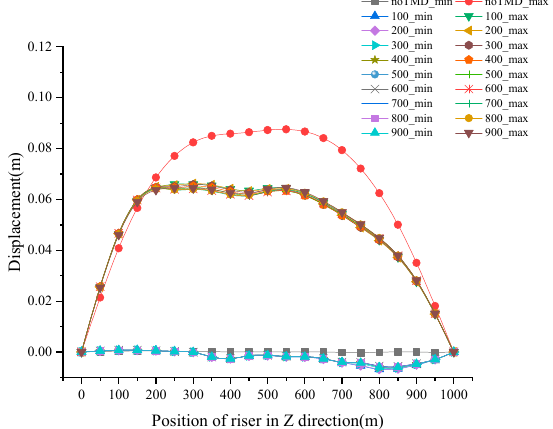
Figure 3. Envelope diagram of the vibration displacement of the riser in the in-line direction when TMD is installed in di ff erent the TMD is installed in different positions.